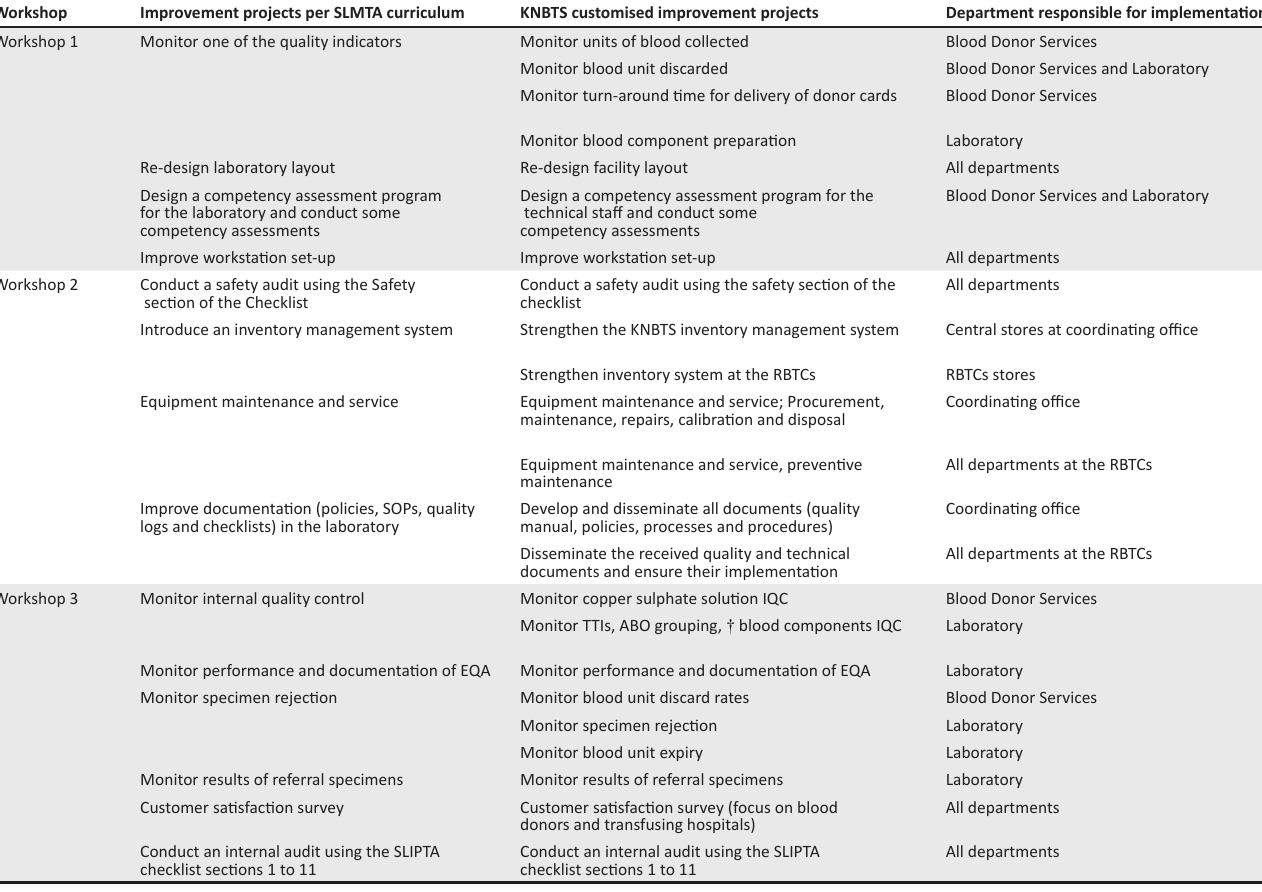
TABLE 1: List of improvement projects at the National Testing Laboratory and regional blood transfusion centres in Kenya, 2013–2015.